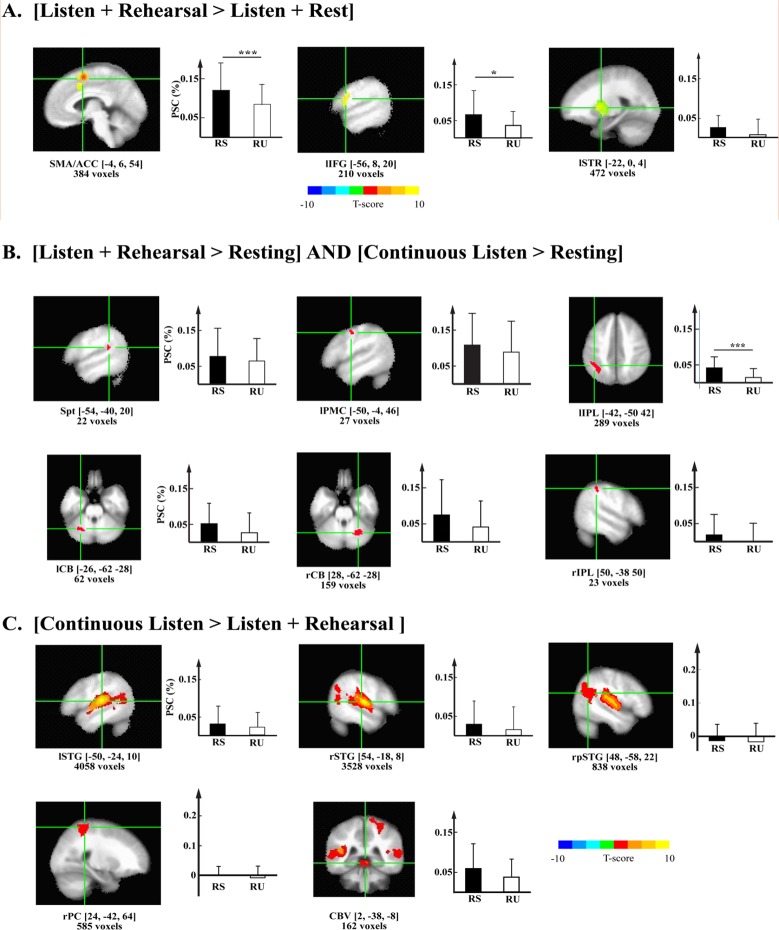
The ROIs and their averaged responses during repetition task performance.(A) The ROIs demonstrated significant stronger activity in ‘Listen + Rehearsal’ condition than ‘Listen + Rest’ condition. From left to right are ROIs with their centers in Supplementary Motor Area (SMA) / Anterior Cingulate Cortex (ACC), left Inferior Frontal Gyrus (lIFG), and left Striatum (lSTR) / Basal Ganglia / Thalamus, respectively. The color bar represented t-score of the contrast. (B) The ROIs demonstrated significant stronger activity in ‘Listen + Rehearsal’ condition than ‘Resting’ condition, and significant difference between ‘Continuous listen’ and ‘Resting’ conditions. From left to right in the top row are plots for ROIs with their centers in Area Spt, left Premotor Cortex (lPMC), and left Inferior Parietal Lobule (lIPL), from left to right in the bottom row are plots for ROIs with their centers in left Cerebellum (lCB), right Cerebellum (rCB), and right Inferior Parietal Lobule (rIPL), respectively. (C) The ROIs demonstrated significant stronger activity in ‘Continuous listen’ condition than ‘Listen + Rehearsal’ condition. From left to right are plots for ROIs with their centers in left Superior Temporal Gyrus (lSTG), right Superior Temporal Gyrus (rSTG), right posterior Superior Temporal Gyrus (rpSTG), right postcentral gyrus (rPC), and cerebellar vermis (CBV), respectively. The colorbar represents the t-score of the contrast. The plot of each ROI has two insets: a sagittal or axial slice image labeling the spatial location of the ROI in MNI space, in which the green crosshair indicates the location of its center of mass, and a bar plot shows the averaged percentage signal change (PSC) in ‘RS’ and ‘RU’ conditions. For the bar plot, the error bars represent standard error of means (SEM). For statistical significance, ‘*’: FWE corrected p < 0.05; ‘***’: FWE corrected p < 0.005.